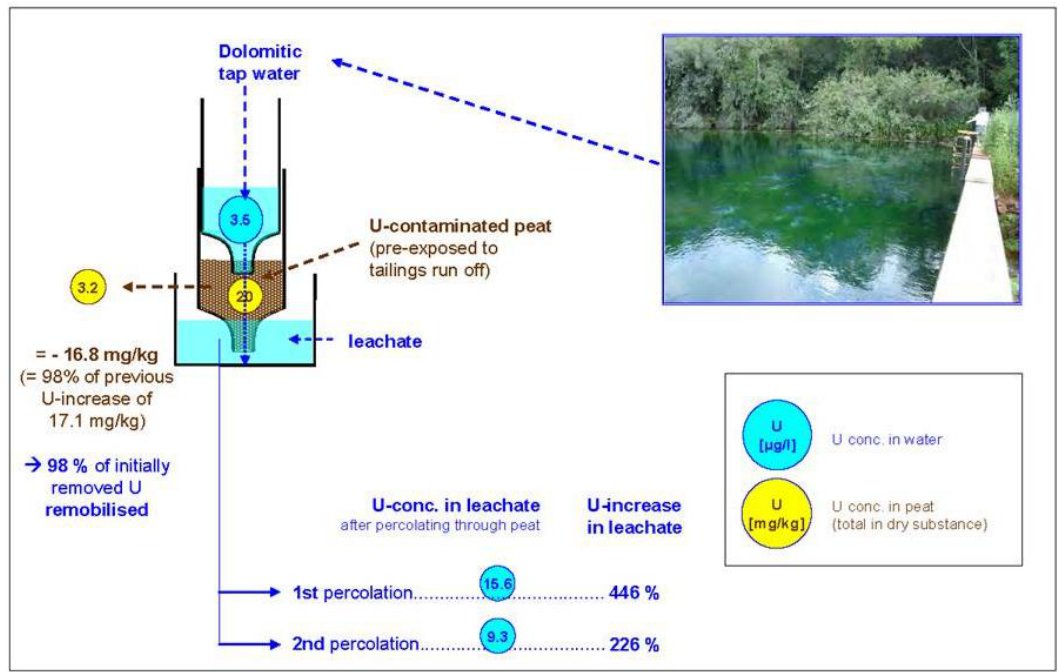
Figure 18. Remobilization of U from runoff-contaminated peat though subsequent exposure to (unpolluted) dolomitic